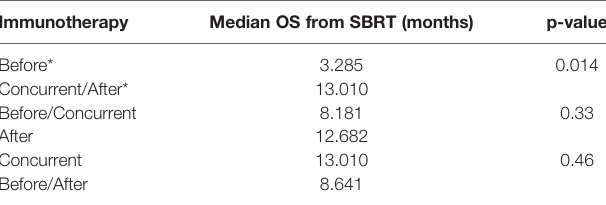
TABLE 2 | Median OS from SBRT in months as calculated from the end of radiation treatment.